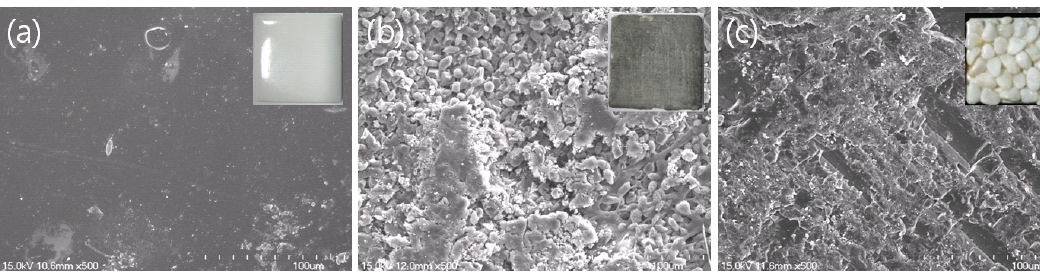
Figure 3 The SEM images of three substrata: ( a ) tile; ( b ) concrete; and ( c )